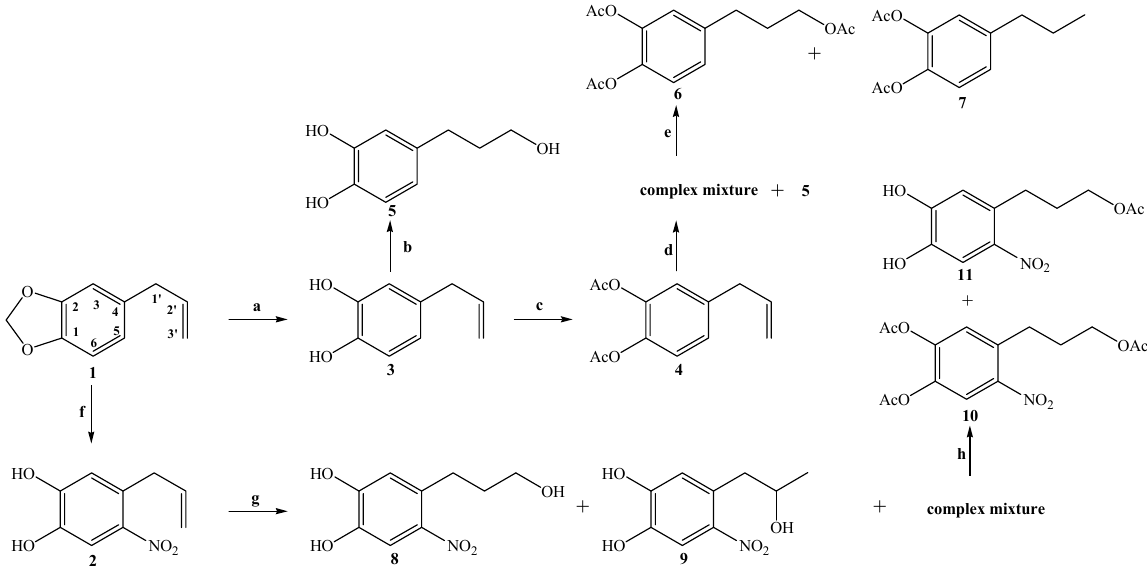
Scheme 1. General scheme of synthesis of derivatives of